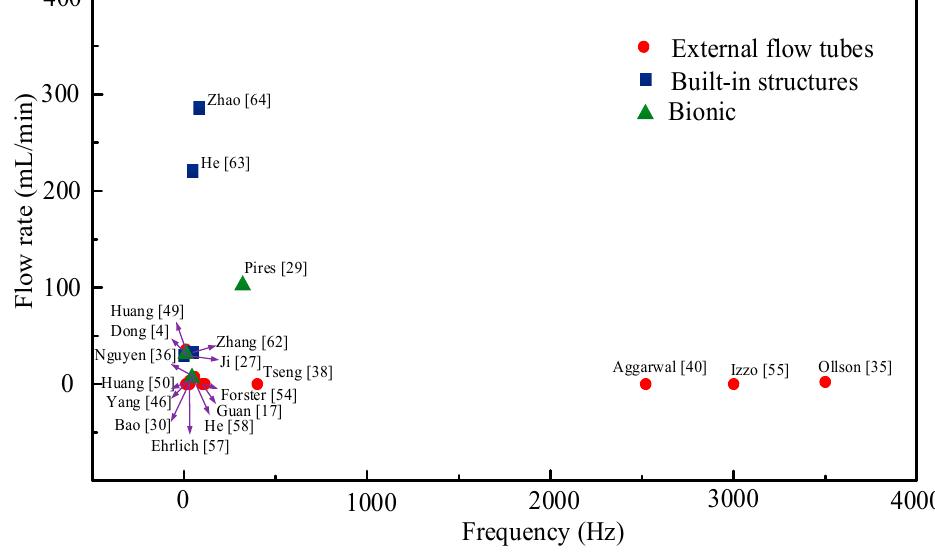
Figure 8. Maximum flow rates for valveless piezoelectric pump: flow rates versus